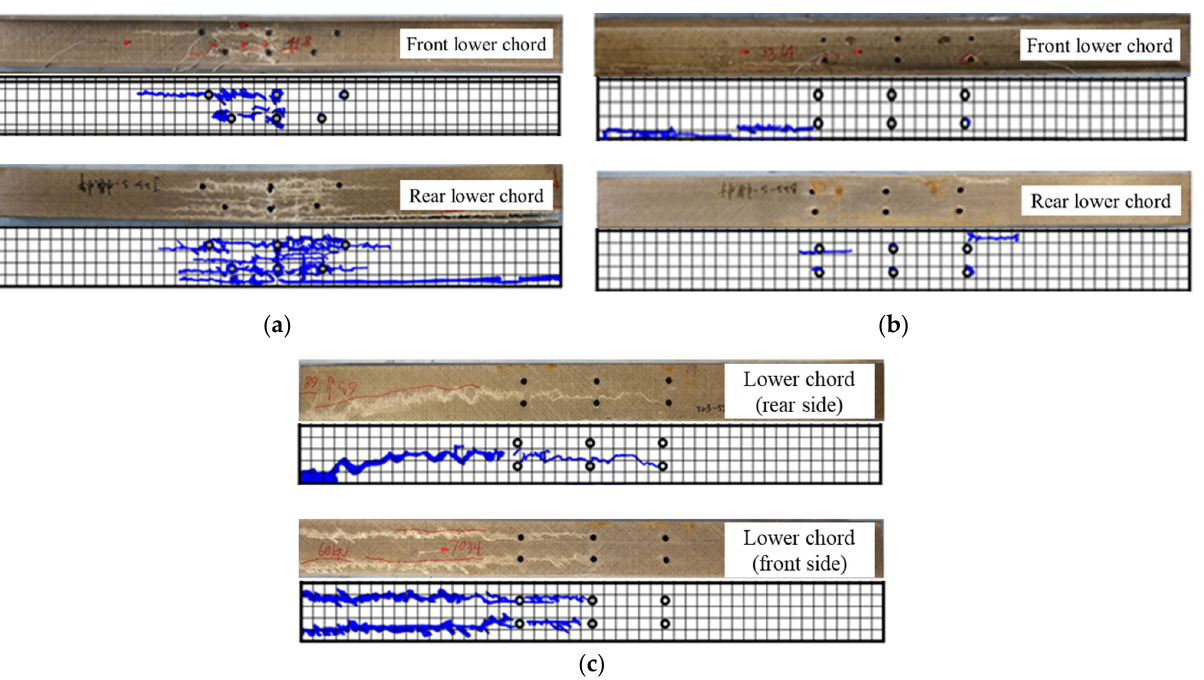
Figure 19. Distribution diagram of cracks in the lower chord: ( a ) specimen BJ, and ( b ) specimen GP, and ( c ) specimen IGP .